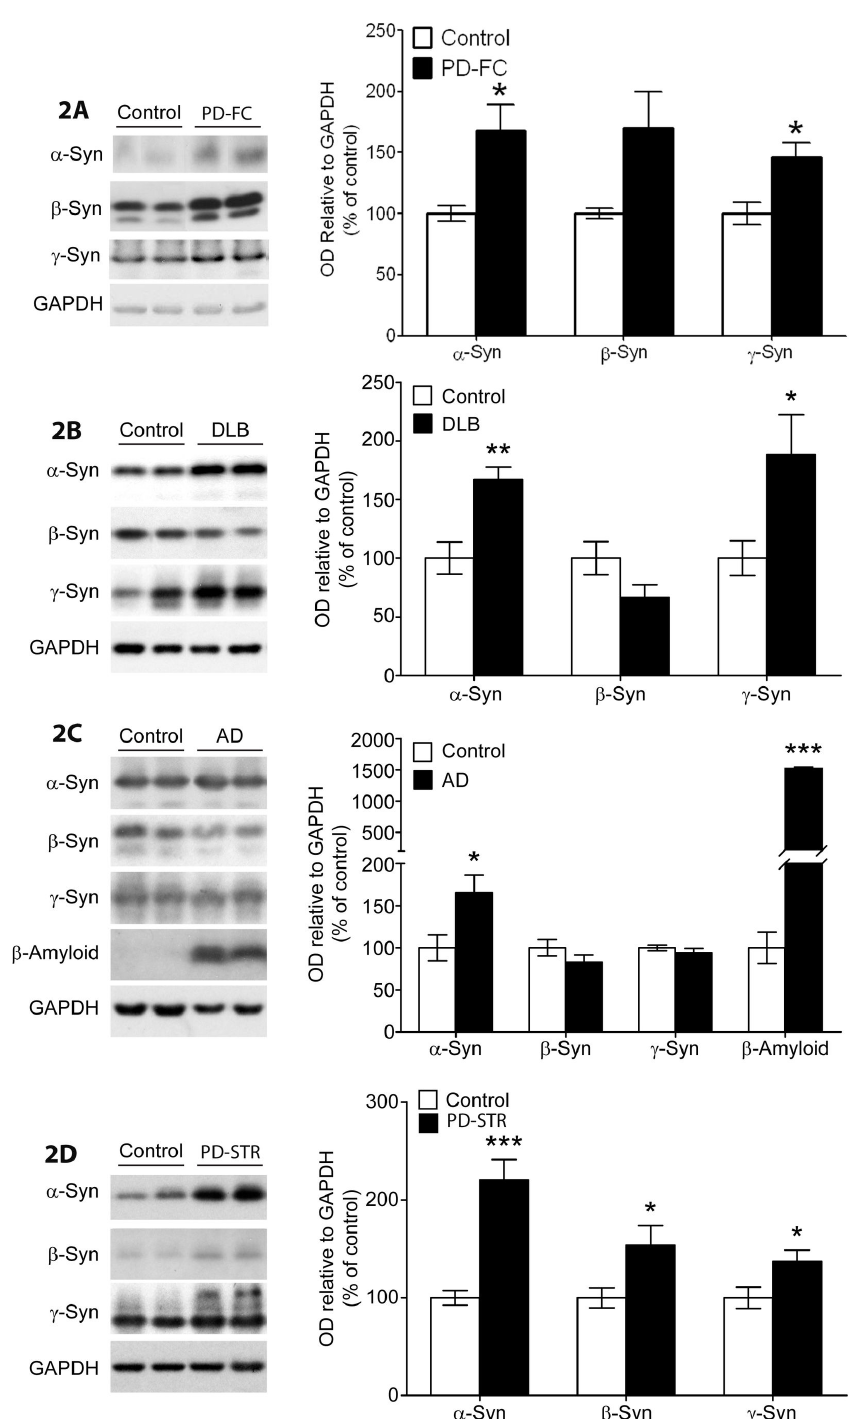
Figure 2. Expression of synuclein proteins in FC of PD, DLB, AD and PD striata. [A] Postmortem PD FC from [N = 7-9] diseased and [N = 7] non-diseased controls, [B] FC from DLB cases [N = 7-10] and non-diseased controls [N = 7-10], [C] FC from AD cases [N = 5-6] and non-diseased controls [N = 4-6], and [D] Striata from PD cases [N = 7-9] and non-diseased controls [N = 7-10]; were analyzed using immunoblots for expression of α-Syn, β-Syn, and γ-Syn, using antibodies listed in Table S1 in File S1. OD of each protein relative to GAPDH is presented as percent of corresponding non-diseased control cases [mean ± SEM]. Data for each Syn protein were analyzed by t-test for difference from corresponding control group [*p<0.05; **p<0.01]. doi: 10.1371/journal.pone.0075025.g002 PLOS ONE |